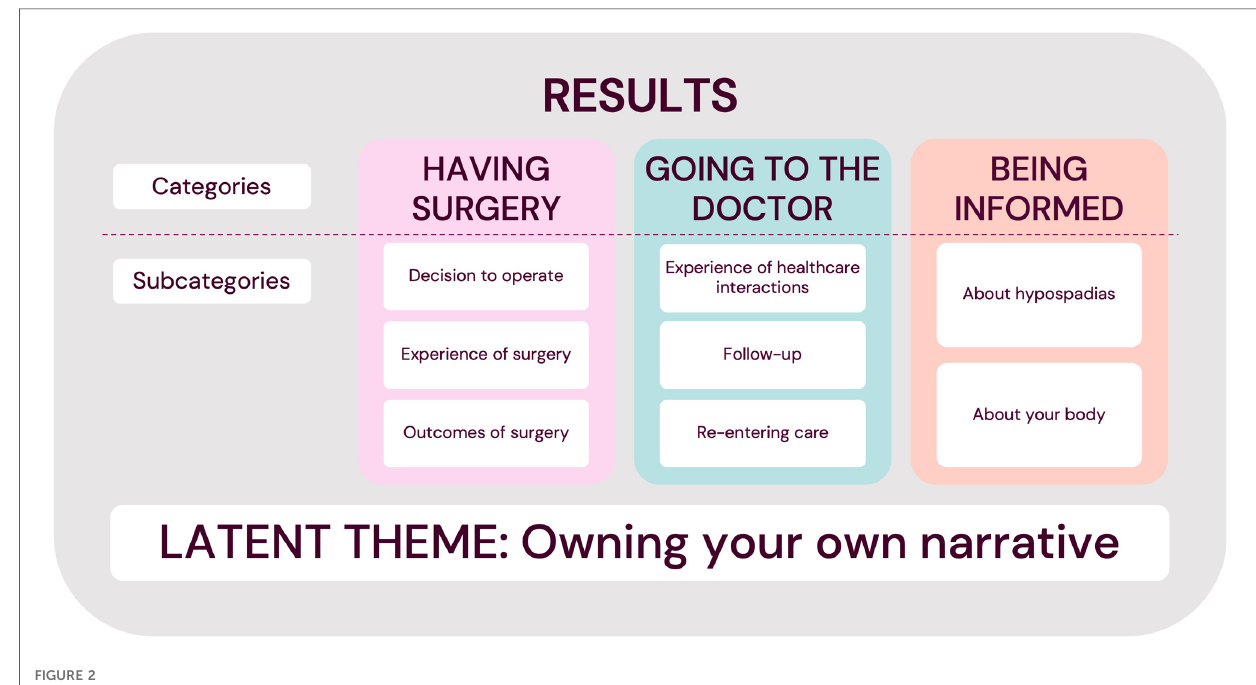
FIGURE 2 Overview of the manifest categories and latent